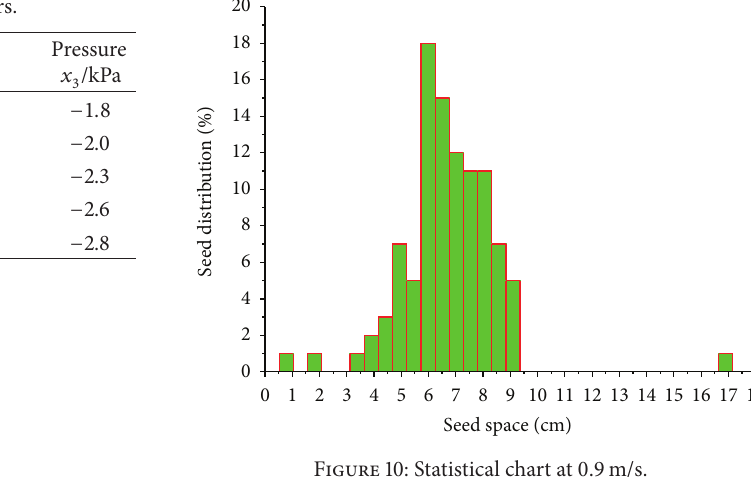
Figure 10: Statistical chart at 0.9 m/s.